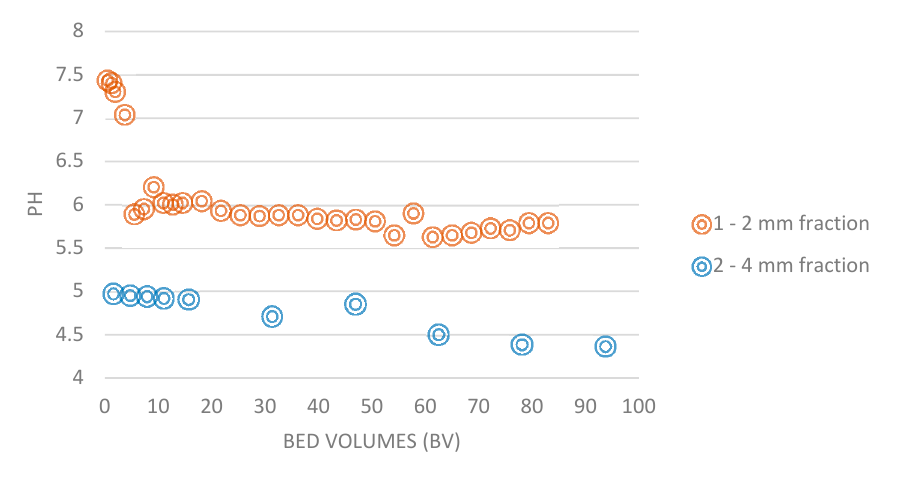
Figure 2. pH measurement of column experiments for Cu(II) (initial pH =